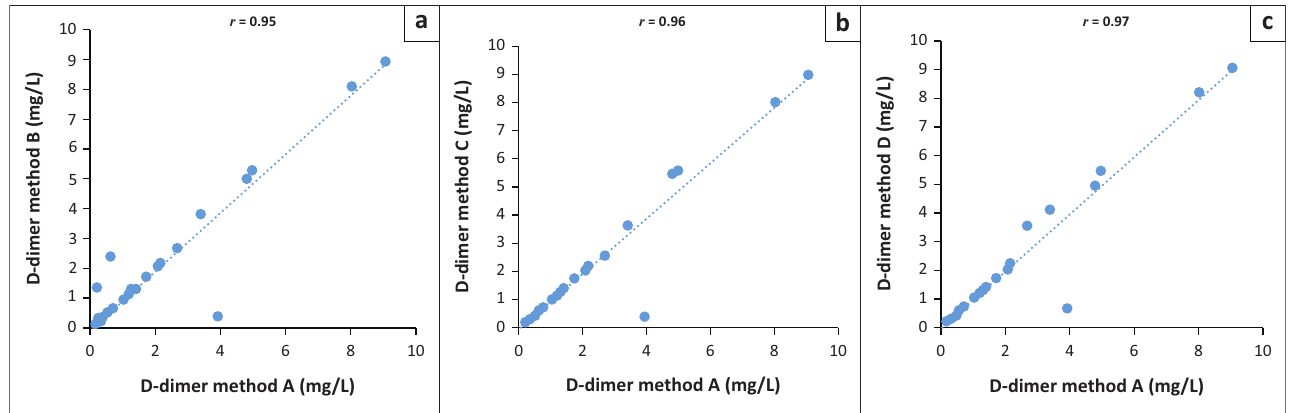
FIGURE 3: Comparisons of D-dimer results between the reference centrifugation (Method A) and Methods B, C and D, Inkosi Albert Luthuli Central Hospital and King Edward VIII Hospital, Durban, KwaZulu-Natal, South Africa, September 2021 – November 2021. Linear regressions for: (a) Method A vs Method B, (b) Method A vs Method C, (c) Method A vs Method